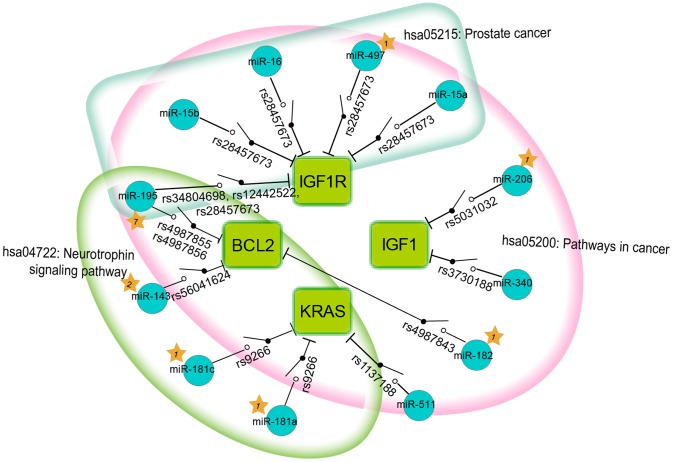
The schematic diagram of miRSNPs→gene→pathway effect of four MG high-risk genes.The green rectangles and blue circles represent the high-risk genes and their regulatory miRNAs respectively. The lines between them show the downregulation of miRNA to genes. The ‘on-off’ symbols sited on the line mean the miRSNPs within miRNA target sites. The peripheral large circles or rectangles denote the pathways that miRSNPs may influence through their effects on miRNAs' regulations to target genes. The orange stars with number inside beside miRNAs stand for the number of literatures validating the inhibition of miRNA to its target gene in Pubmed database.